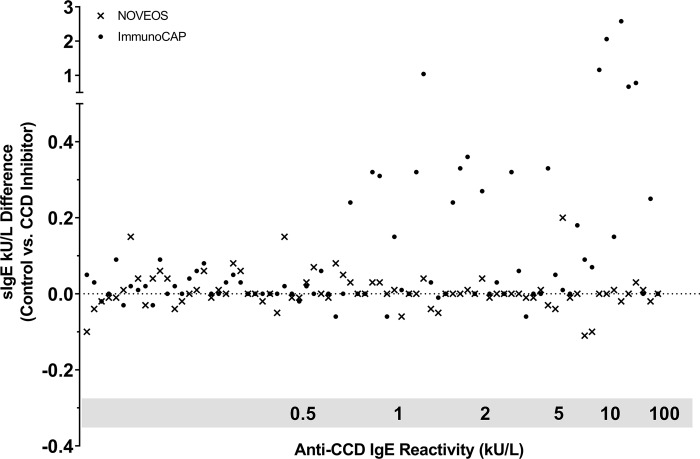
Negative to low-positive specific IgE results (< 3 kU/L) on ImmunoCAP and NOVEOS organized side-by-side in increasing CCD anti-IgE reactivity.Comparing IgE concentration difference with and without CCD inhibitor addition to the serum.